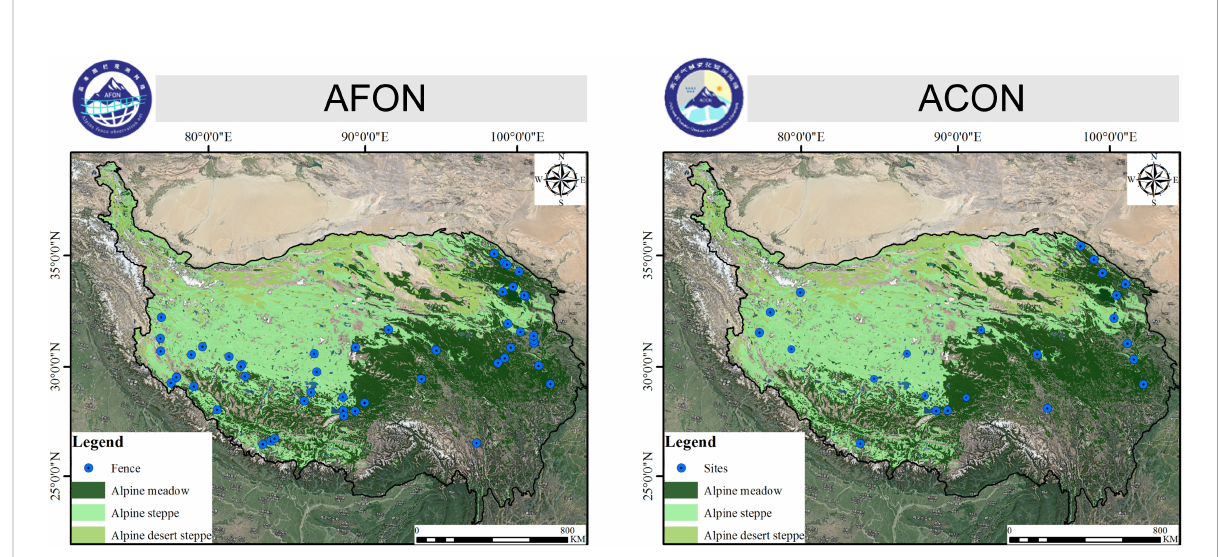
FIGURE 1 Locations of the Alpine Fence Observation Net (AFON) and the Alpine Climate Change Observation Net (ACON) on the TP. Both AFON and ACON are constructed by Prof. Sun ’ team at the Institute of Tibetan Plateau Research, Chinese Academy of